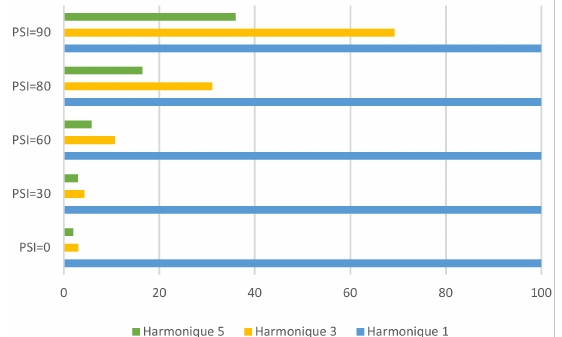
Figure 12. Percent of harmonics “3,5” with respect to the harmonic “1” vs. angle control ( ψ ).